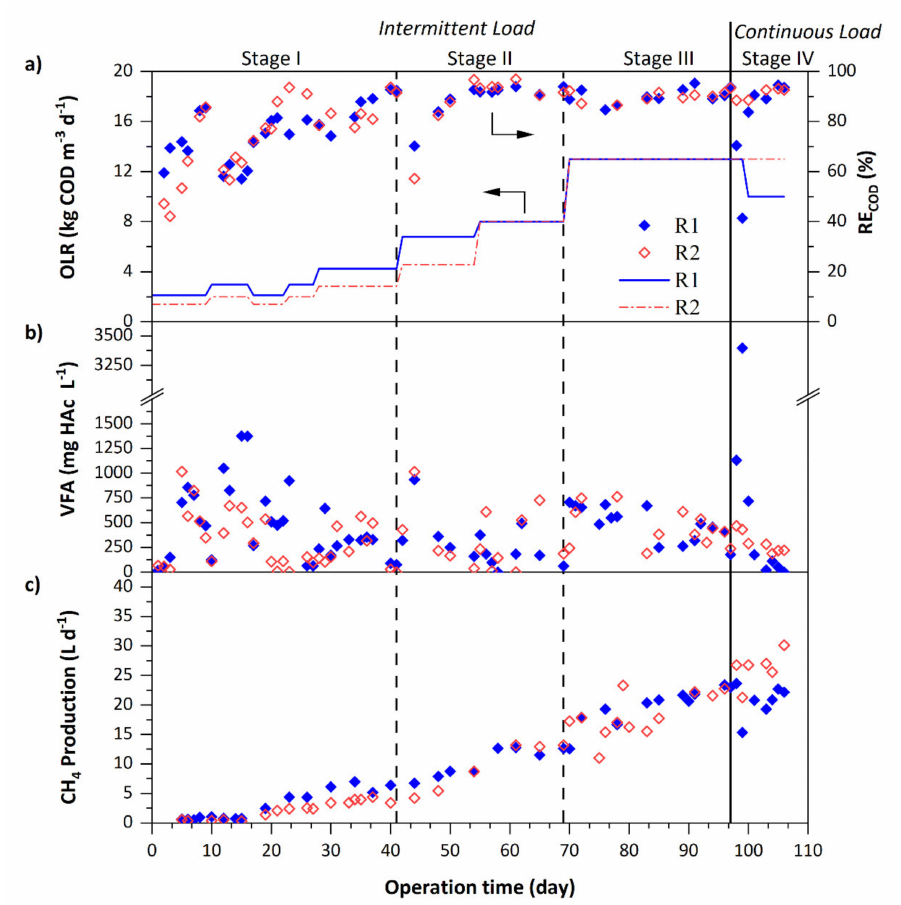
Figure 2. Performance of the anaerobic sludge bed reactors. ( a ) Organic load applied (—) and soluble COD removal efficiency ( (cid:7) , ♦ ), ( b ) VFA concentration in the effluent of the reactors ( (cid:7) , ♦ ), ( c ) methane production ( (cid:7) , ♦ ). R1 operated at U L ≤ 0.15 m h − 1 and R2 operated at U L = 3.0 m h − 1